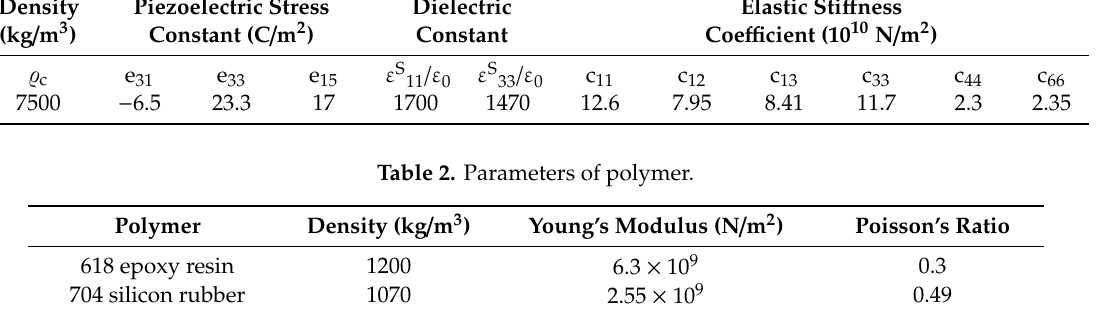
Table 1. Parameters of PZT-5H.